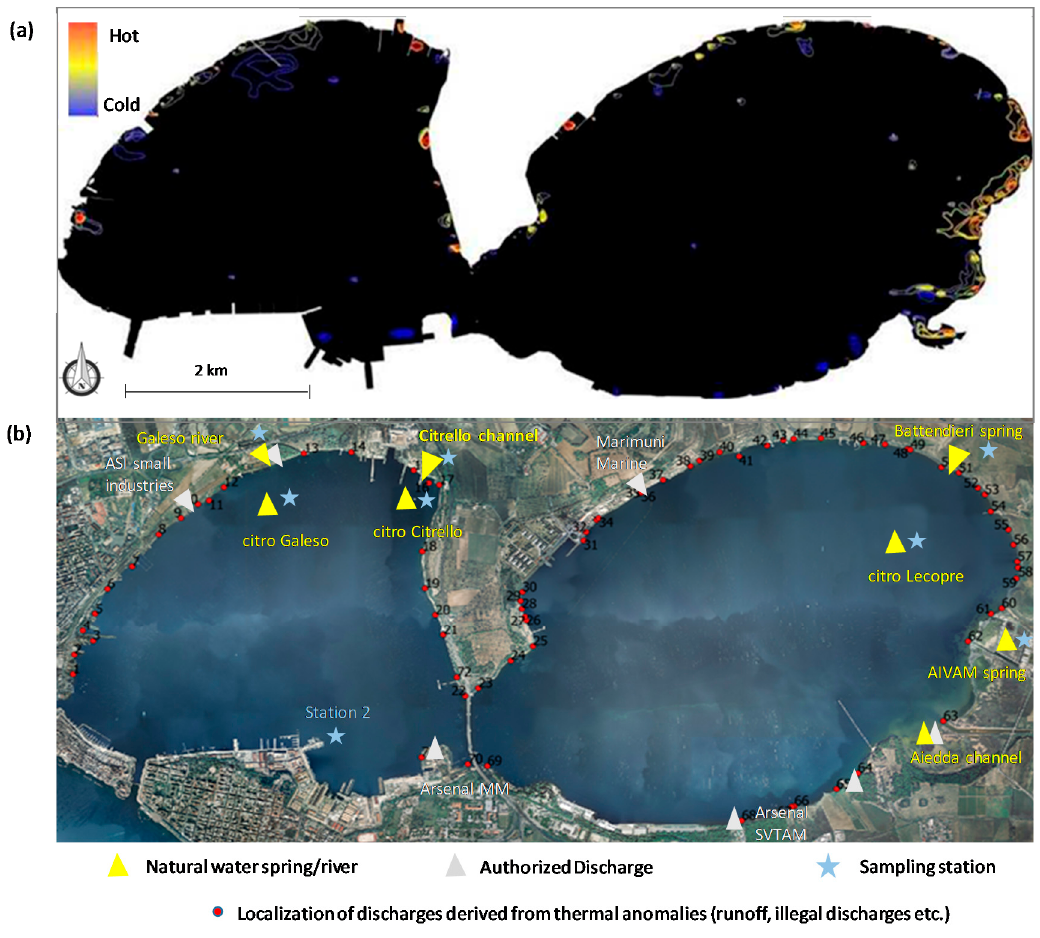
Figure 4. ( a ) Map of thermal anomalies and ( b ) localization of discharges (adapted from [31]). Mar Piccolo is subjected to both private (Military Arsenal) and public sewage